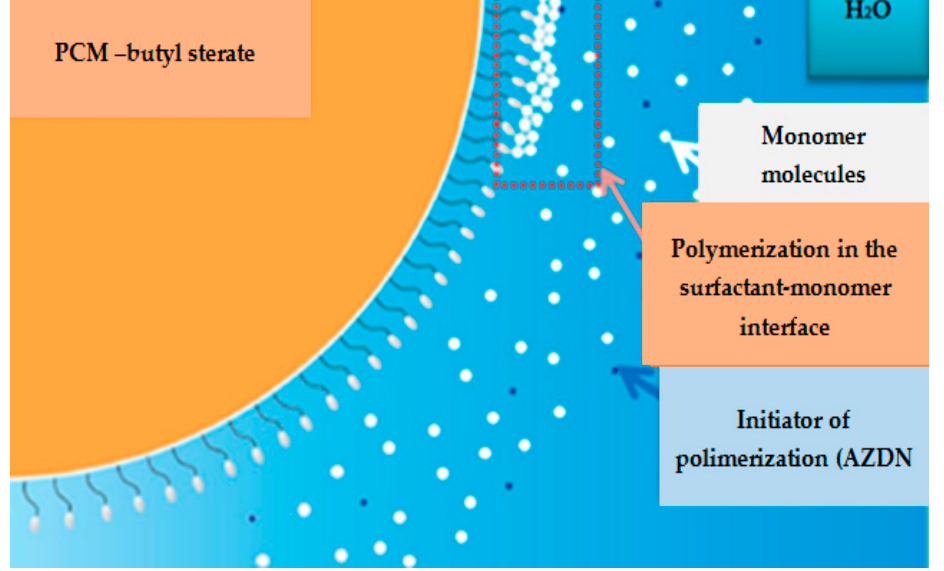
Figure 2. Schematic representation of the complex coacervation polymerization process for a PCM.